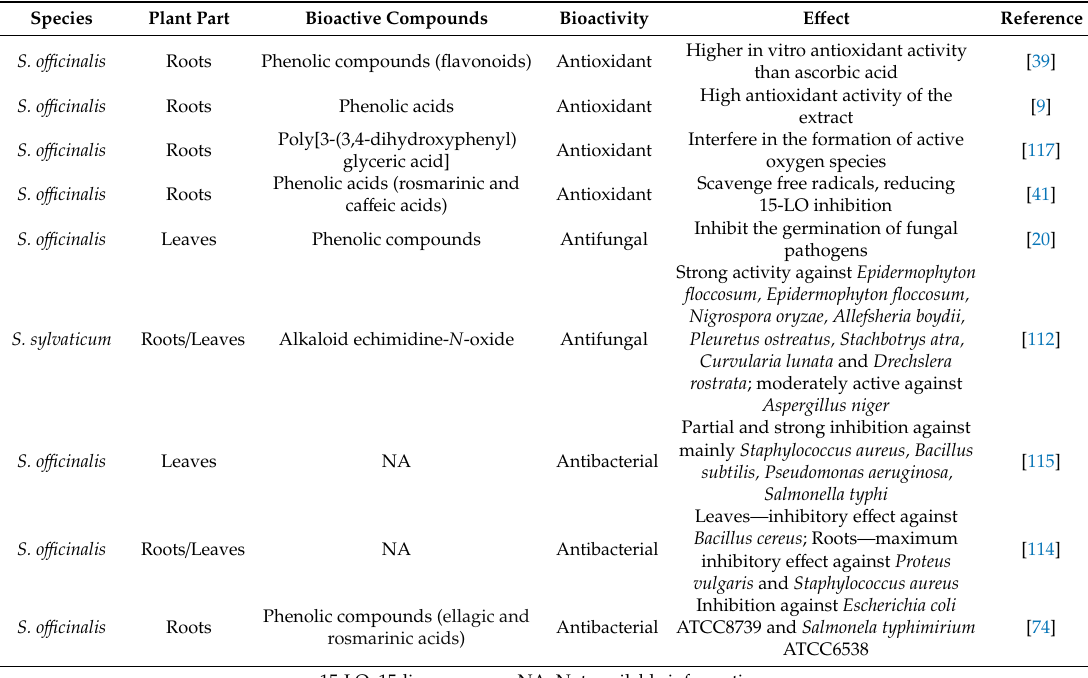
Table 3. Bioactivities of di ff erent Symphytum